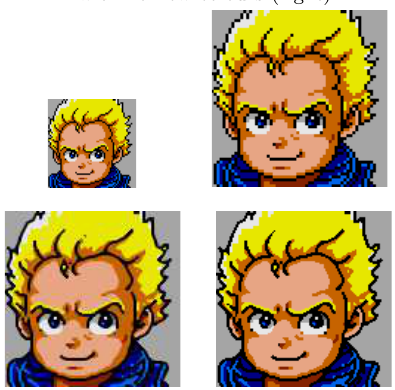
Fig. 6. At the top: the original ‘man’ image (left) and the pixel replicated image for magnification by a factor 2 (right), at the bottom: our new morphological interpolation method (left) and the result of our method with no new colours